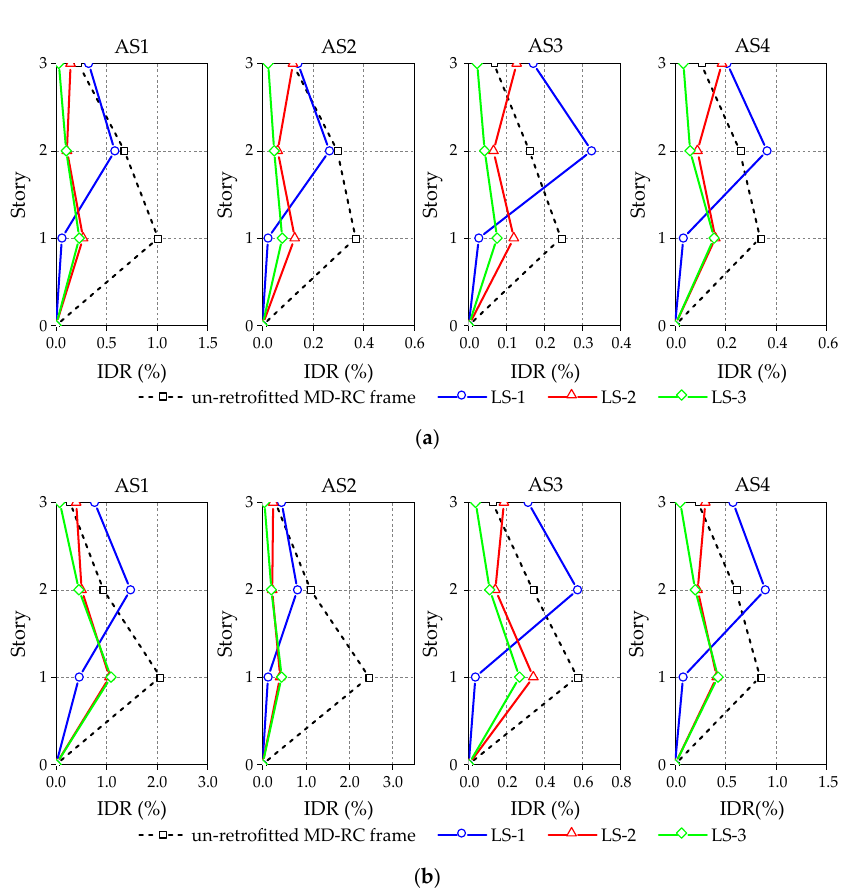
Figure 12. IDR distribution of MS1 MD ‐ RC frame with DS1 ( a ) and DS2 ( b ) damage state before and after retrofitting.